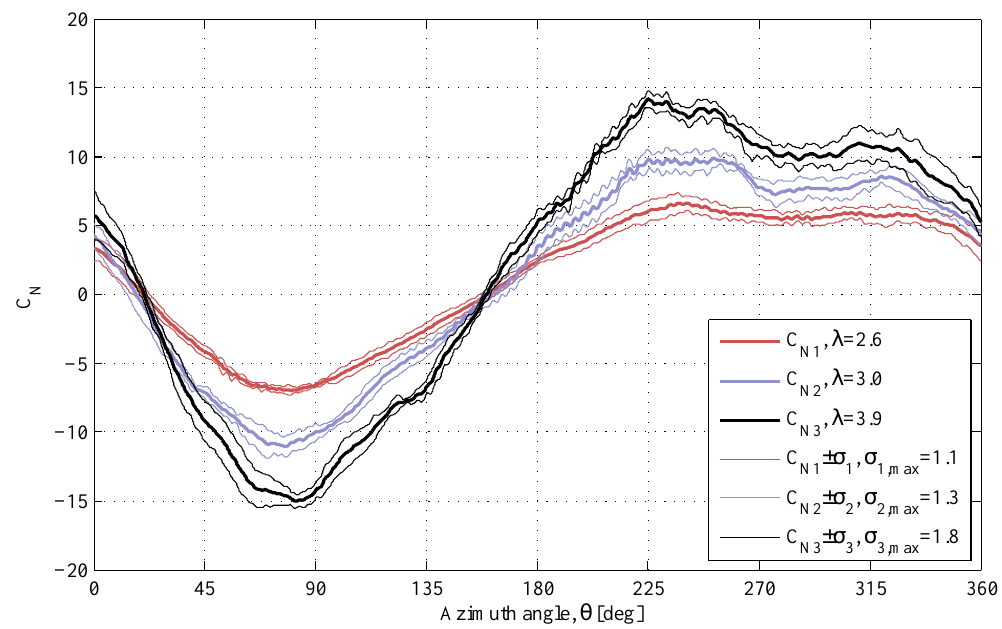
Figure 9. The average normal force coefficient at the turbine rotational speed of 50 rpm.